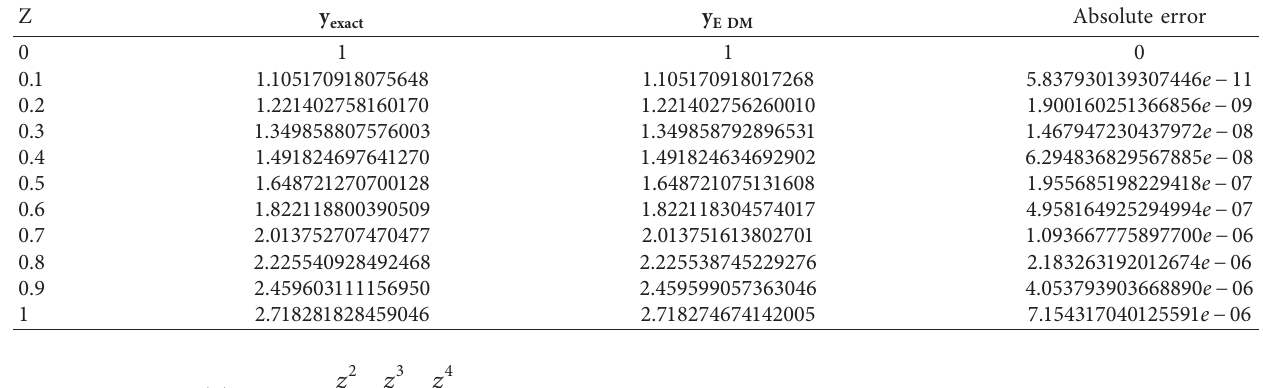
Figure 2: Comparing the numerical solution y Table 3: The numerical approximation y